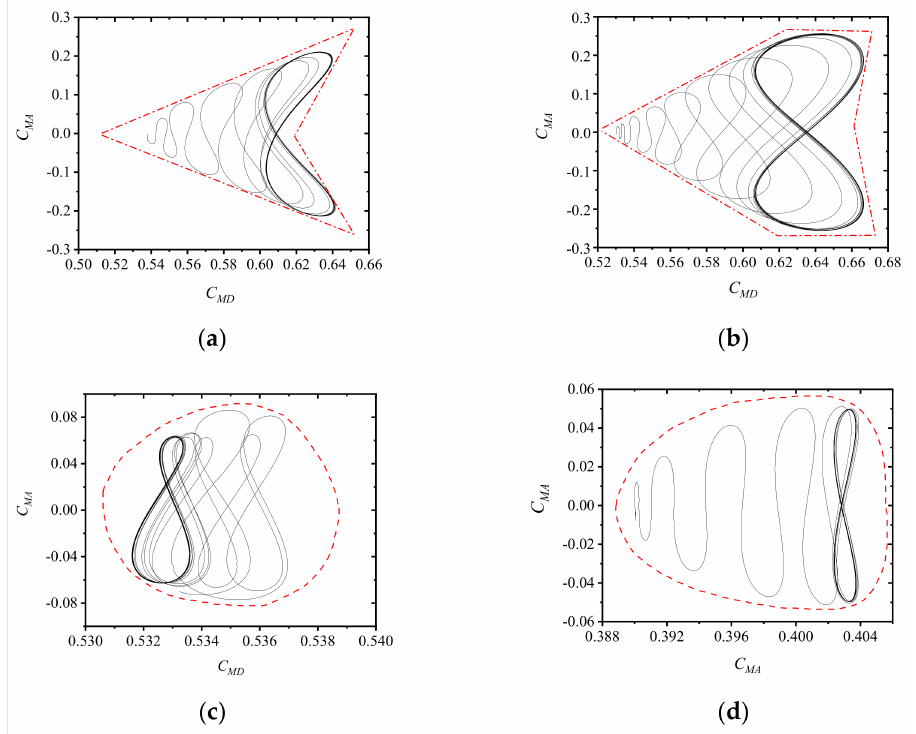
Figure 14. Phase plane trajectory diagrams for crosswind and downwind basal moment coefficients ( C MA and C MD ). ( a ) Case 1. The target model, θ = 0 ◦ ; ( b ) Case 2. The reference model, θ = 0 ◦ ; ( c ) Case 3. The target model, θ = 90 ◦ ; ( d ) Case 4. The reference model, θ = 90 ◦ .